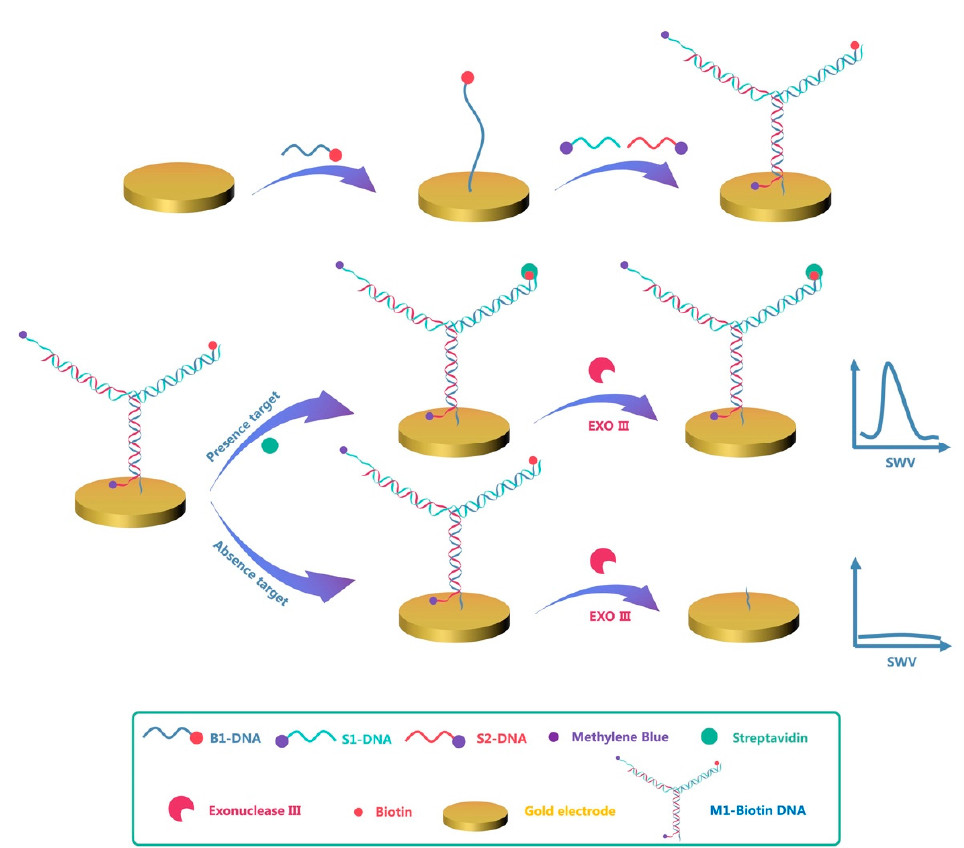
Figure 1. Design and signal mechanism of the electrochemical DNA sensor based on terminal protection. In the absence of SA, M1-Biotin DNA gradually hydrolyzes from the 3’ end of the modified biotin under the action of EXO III until no M1-Biotin DNA remains on the electrode. When M1-Biotin DNA is digested by EXO III, the S1-DNA and S2-DNA modi- fied with the reporter molecule MB is removed from the electrode, meaning only a small electrochemical signal is detected. In the presence of SA, M1-Biotin DNA specifically binds with SA to generate M1-Biotin-SA DNA, which protects M1- Biotin DNA from EXO III digestion, meaning M1-Biotin DNA remains on the electrode surface. Due to the presence of MB on M1-Biotin-SA DNA and the proximity of the MB reporter molecule to the gold electrode surface, a large electrochemical detection signal is generated.